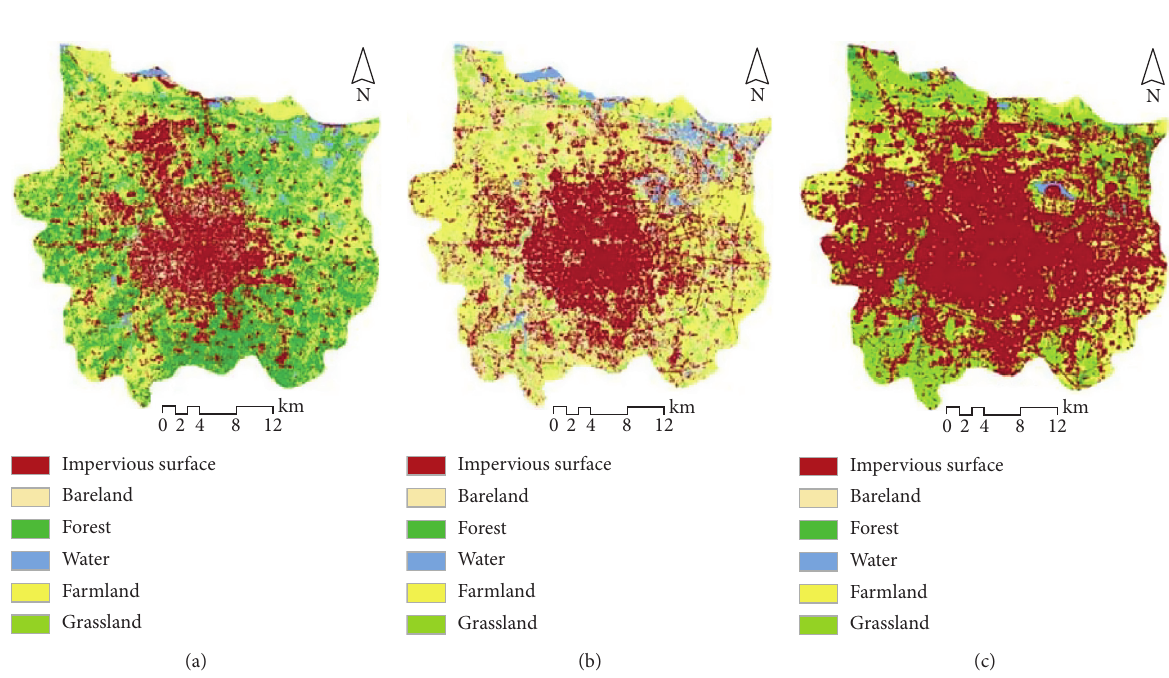
Figure 4: The LULC maps of Zhengzhou City in (a) 2000, (b) 2006, and (c) 2014.